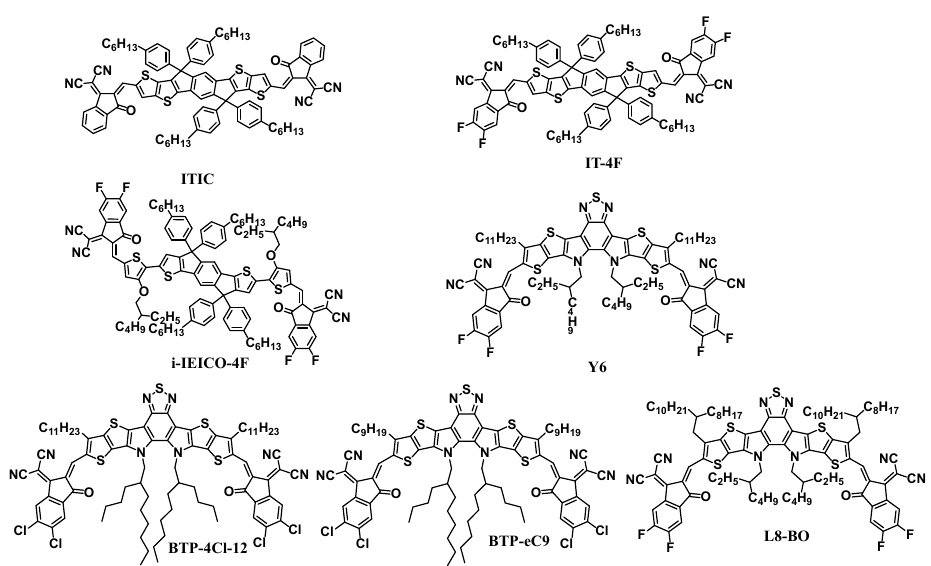
Figure 3. High efficiency printable acceptor materials listed in Table 1.